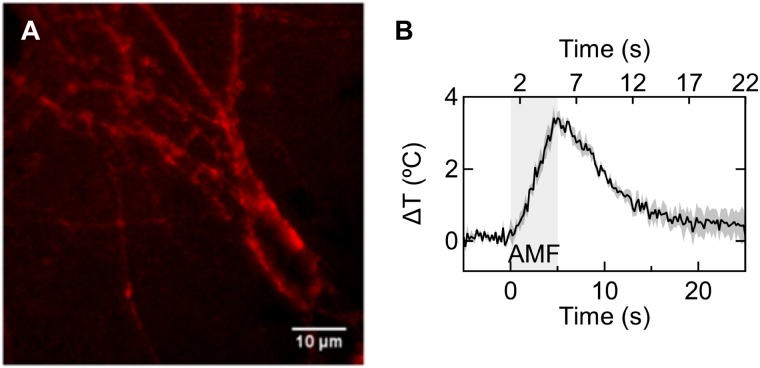
Nanoparticle heating on the neuronal membrane. (A) Fluorescence micrograph showing magnetic nanoparticles coated with Alexa fluor-647 labeled NeutrAvidin attached to the neuronal membrane in a rat hippocampal culture via biotinylated anti-A2B5 antibody. (B) Plot shows average temperature rise in magnetic nanoparticle decorated membrane under 5 s magnetic field (n = 3). Bottom axis shows time relative to AMF start, and top axis shows 5 s time bins when significant temperature points are achieved (e.g., 2–7 s = 1–3°C, 7–12 s = 3–1°C, 17–22 s <1°C above the starting temperature).